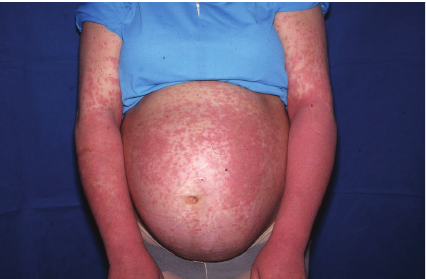
Figure 3: Pruritic urticarial rash in